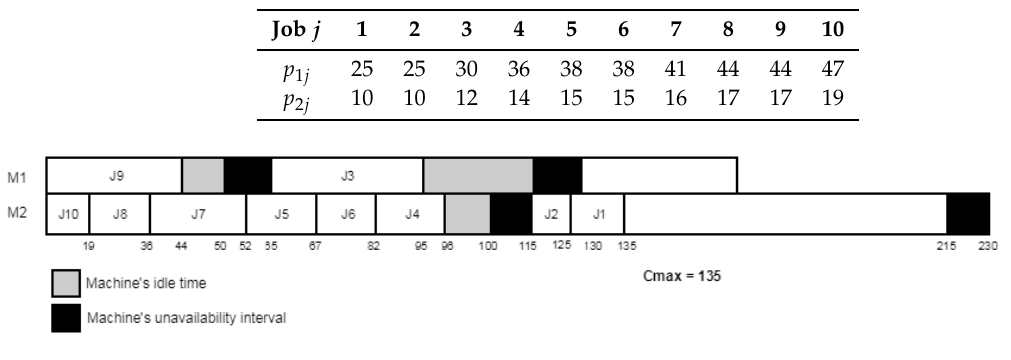
Figure 2. Gantt chart of solution generated by LPTBH .